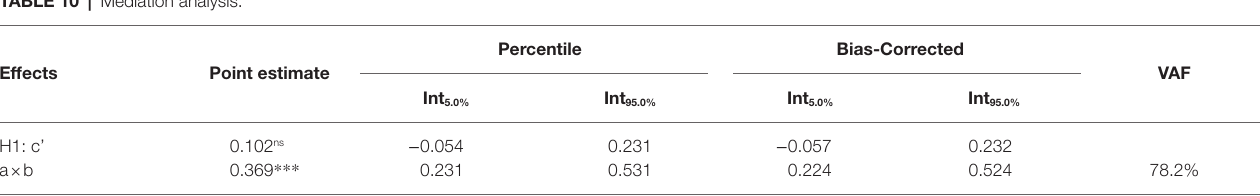
TABLE 10 | Mediation